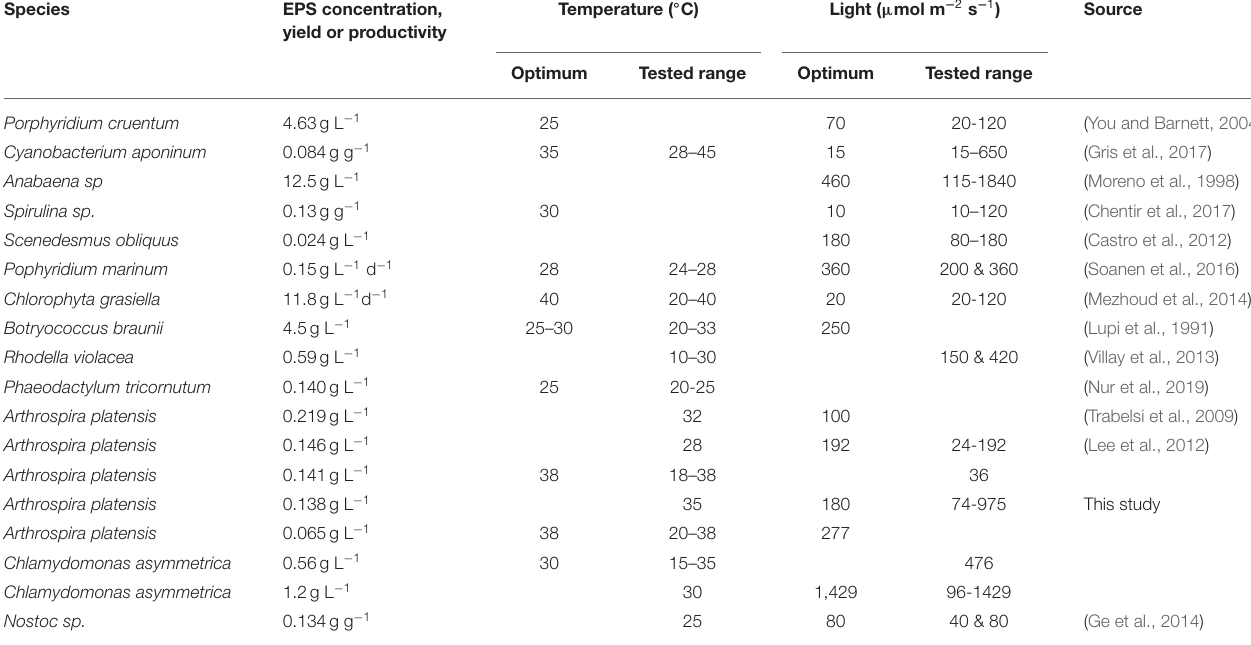
TABLE 1 | Influences on light and temperature on EPS production in different photoautotrophic microorganisms.